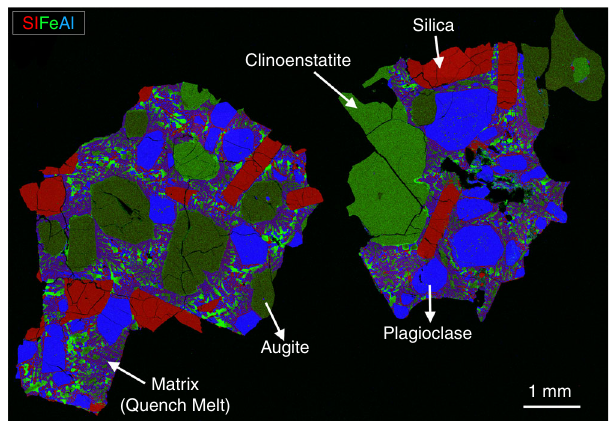
Fig. 2 False-colored X-ray map of NWA 11119 showing mm-sized phenocrysts of silica, clinoenstatite, augite, and plagioclase. Zoning was not observed in silica or pyroxene phenocrysts, but normal zoning appears in plagioclase phenocrysts. The phenocrysts are surrounded by quenched groundmass consisting of highly zoned crystals that range in size from submicrometer to hundreds of